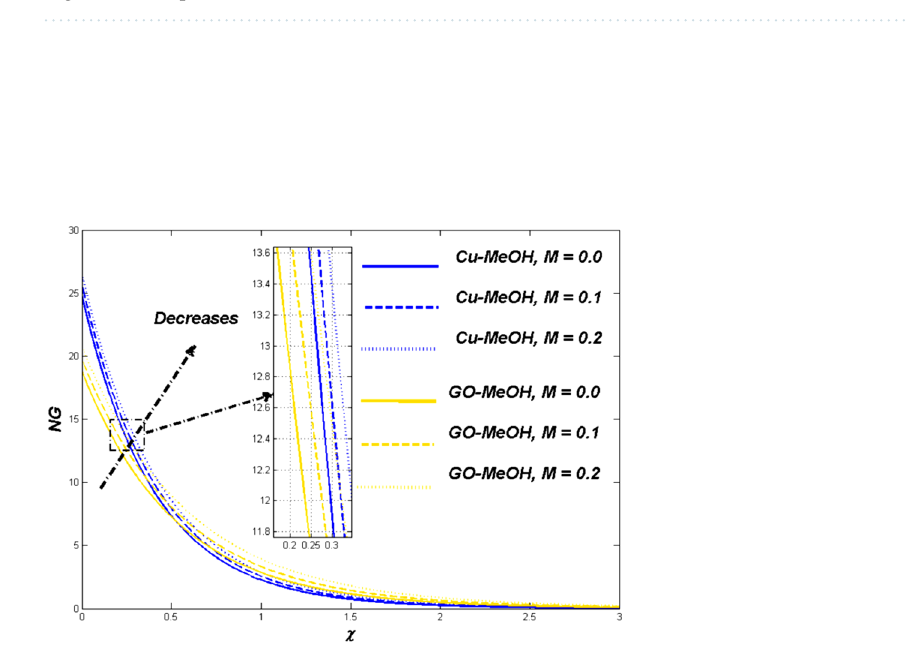
Figure 9. Entropy variation versus M